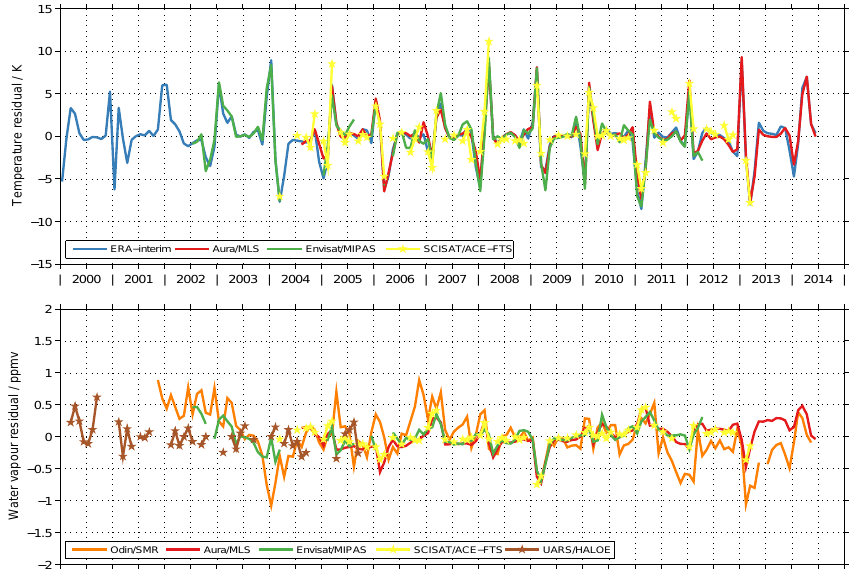
Figure 12. Same as Fig. 2, but for